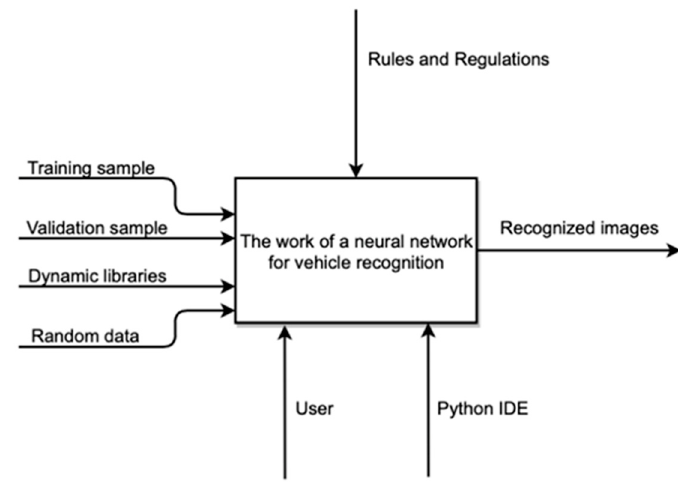
Figure 1. Contextual diagram of the system functioning.